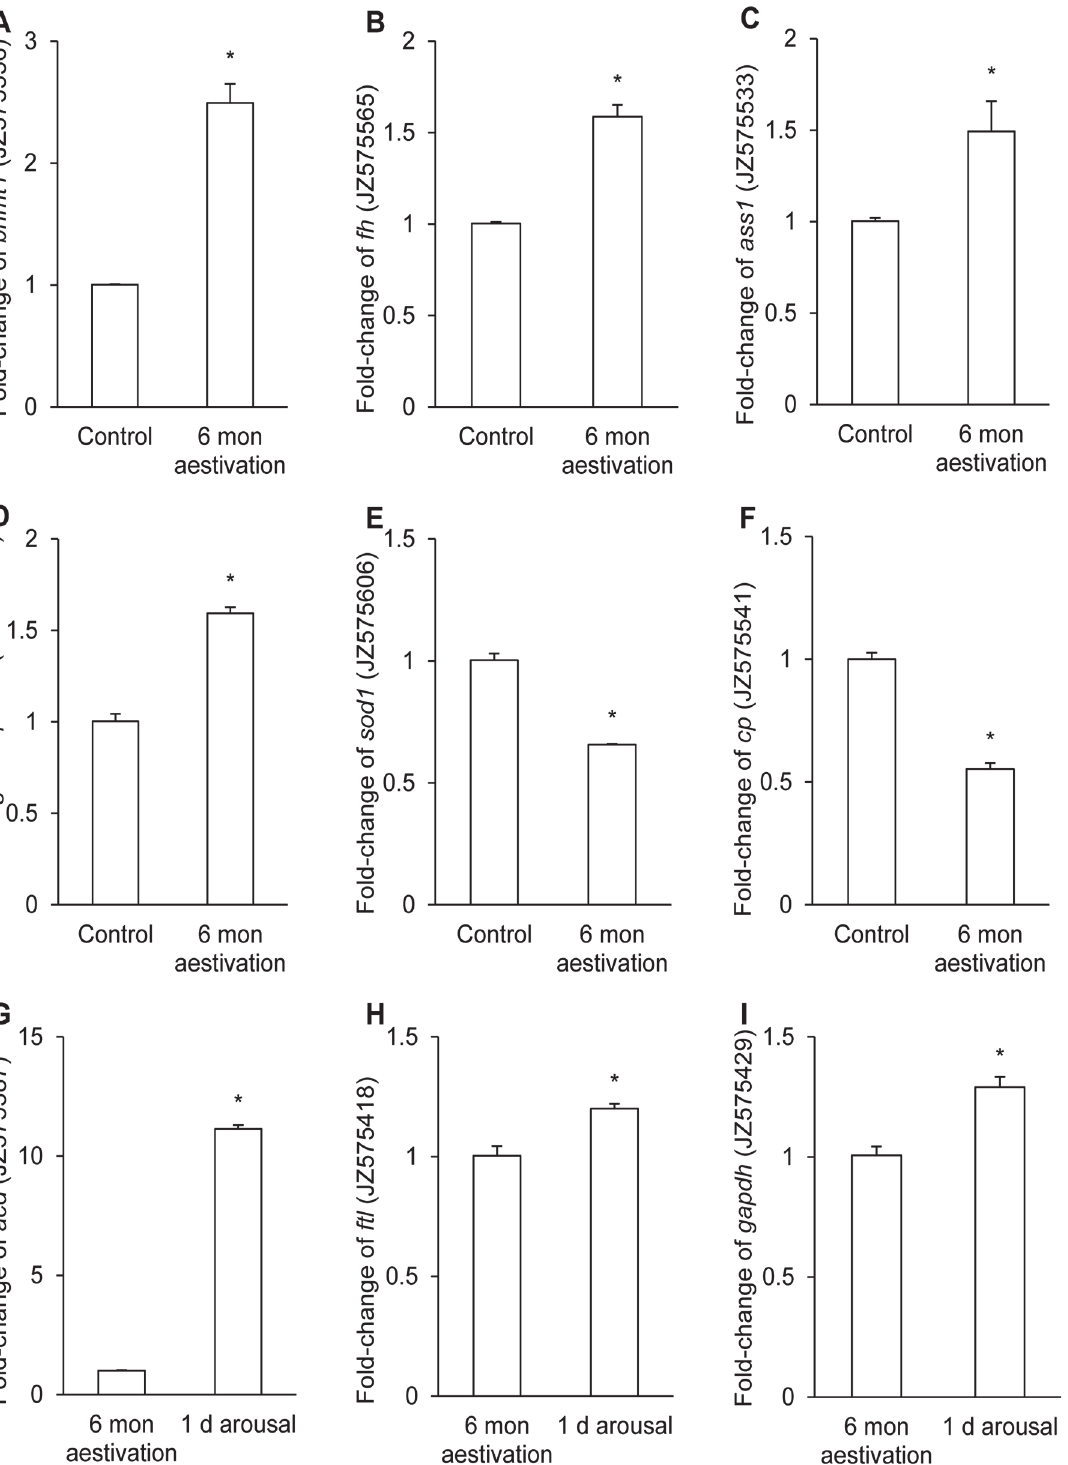
Fig 1. Quantitative RT-PCR results of selected genes that were differentially expressed in the SSH libraries. Relative quantification of mRNA expression (fold change) of (A) betaine-homocysteine S-methyltransferase 1 ( bhmt1 , JZ575536), (B) fumarate hydratase ( fh , JZ575565), (C) argininosuccinate synthetase 1 ( ass1 , JZ575533), (D) carbamoyl-phosphate synthetase III ( cpsIII , JZ575539), (E) superoxide dismutase 1 ( sod1 , JZ575606), (F) ceruloplasmin ( cp , JZ575541), (G) acyl-CoA desaturase ( acd , JZ575387), (H) ferritin light chain ( ftl , JZ575418) and (I)